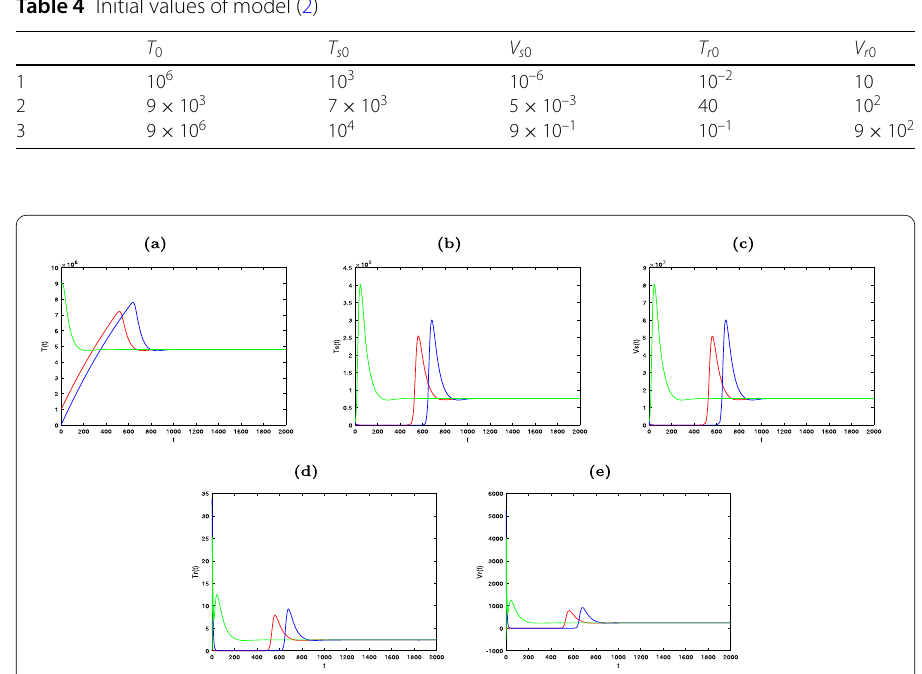
Example 4 In model (2), we take the parameters λ = 10 5 , d = 0.005, k s = 1.2 × 10 –8 , k r = 1.0 × 10 –8 , u = 3 × 10 –5 , δ = 1, N s = 2000, N r = 1000, c = 10, ω 1 = 10 –8 , and α 1